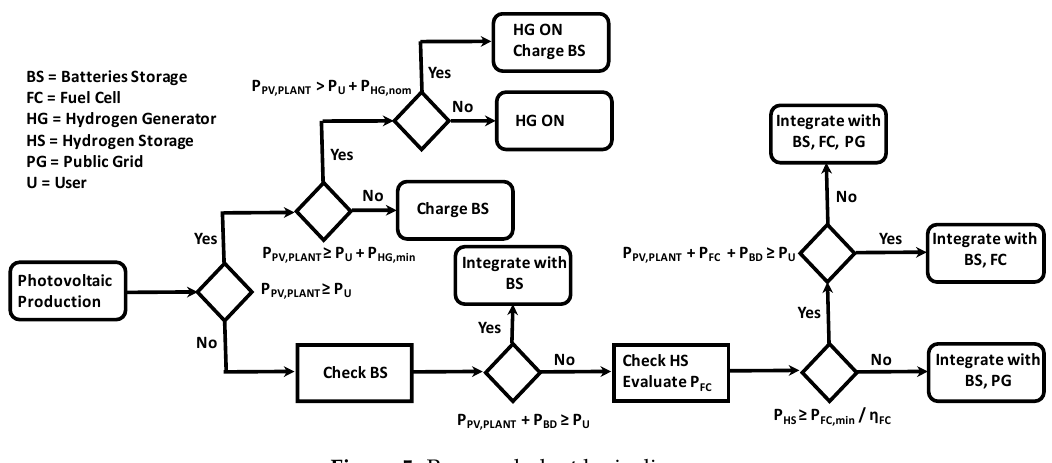
Table 1. Main characteristic of the hydrogen-based microgrid [20–22].